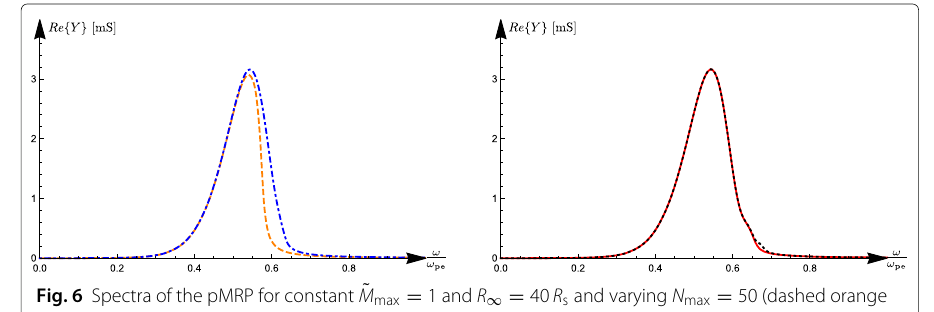
Fig. 6 Spectra of the pMRP for constant ˜ M max = 1 and R ∞ = 40 R s and varying N max = 50 (dashed orange line), N max = 75 (dot-dashed blue line), N max = 100 (bold red line) and N max = 125 (dotted black line)